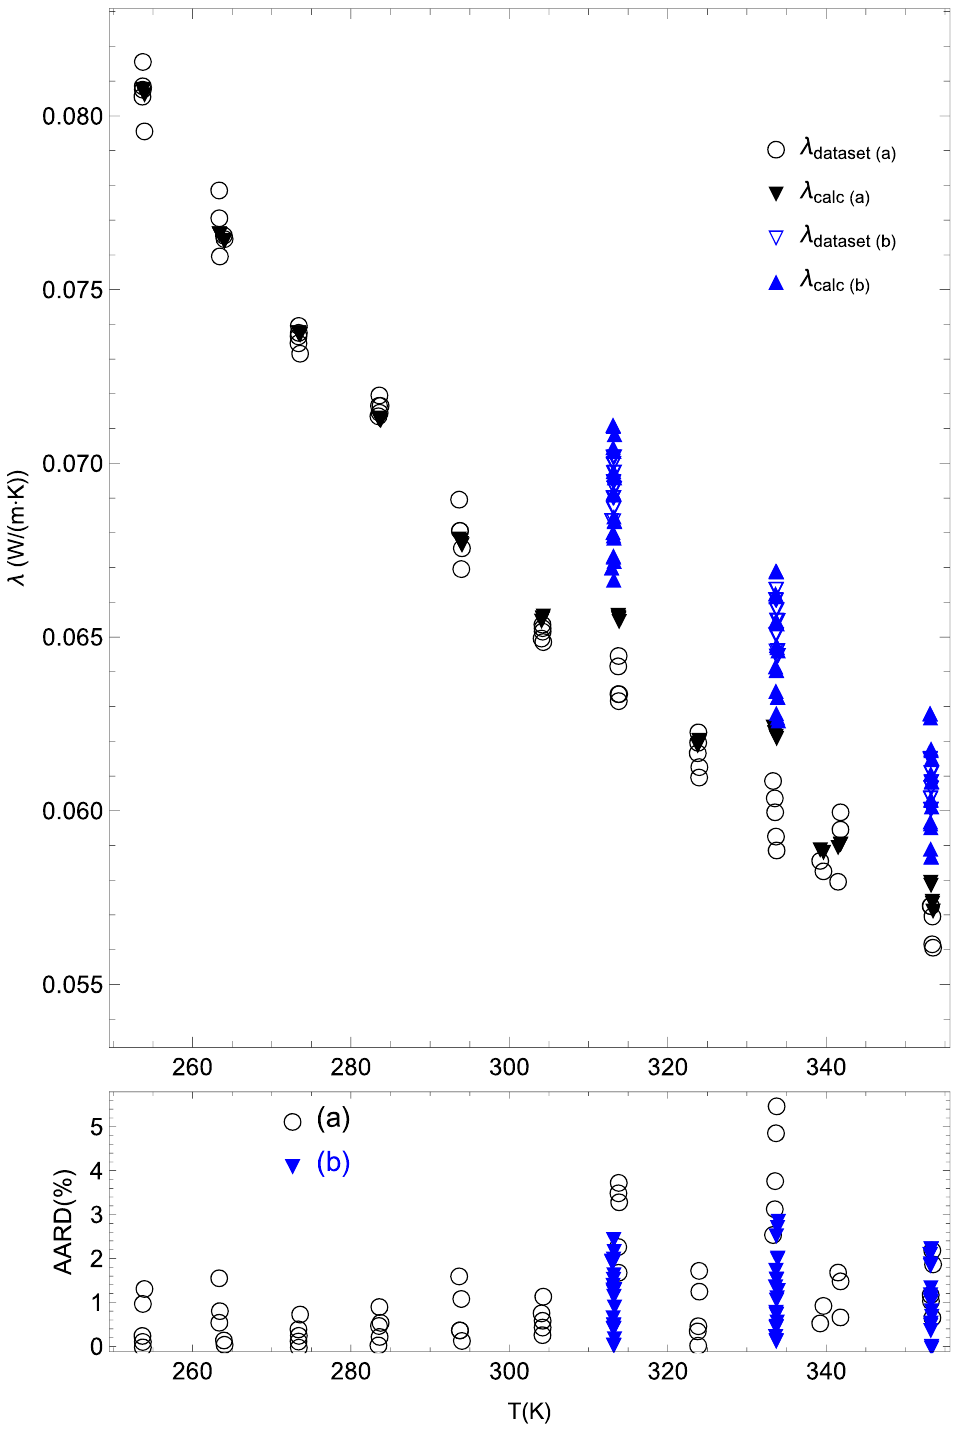
Figure 3. Behavior of R1336mzz(E) and absolute relative average percent deviation related to experimental temperature. (a) corresponds to Ref [40] and (b) corresponds to Ref [39].